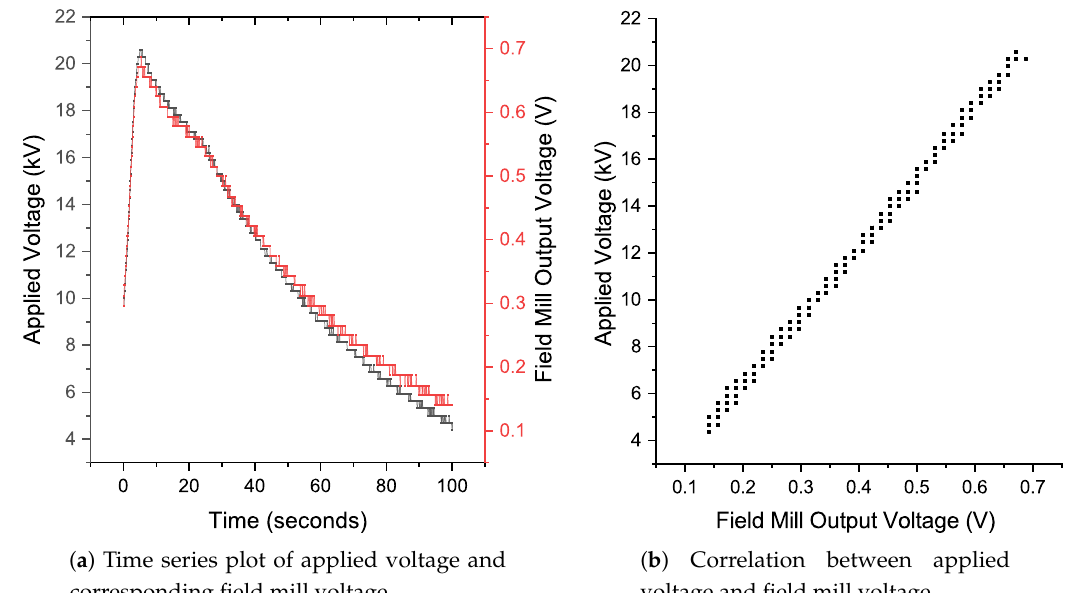
Figure 5. A 4 to 20 kV DC signal is applied to the horizontal bar to simulate the general shape of a decaying exponential. ( a ) shows the time series plot of applied voltage and resulting field mill voltage and ( b ) shows the scatter plot of applied voltage versus field mill